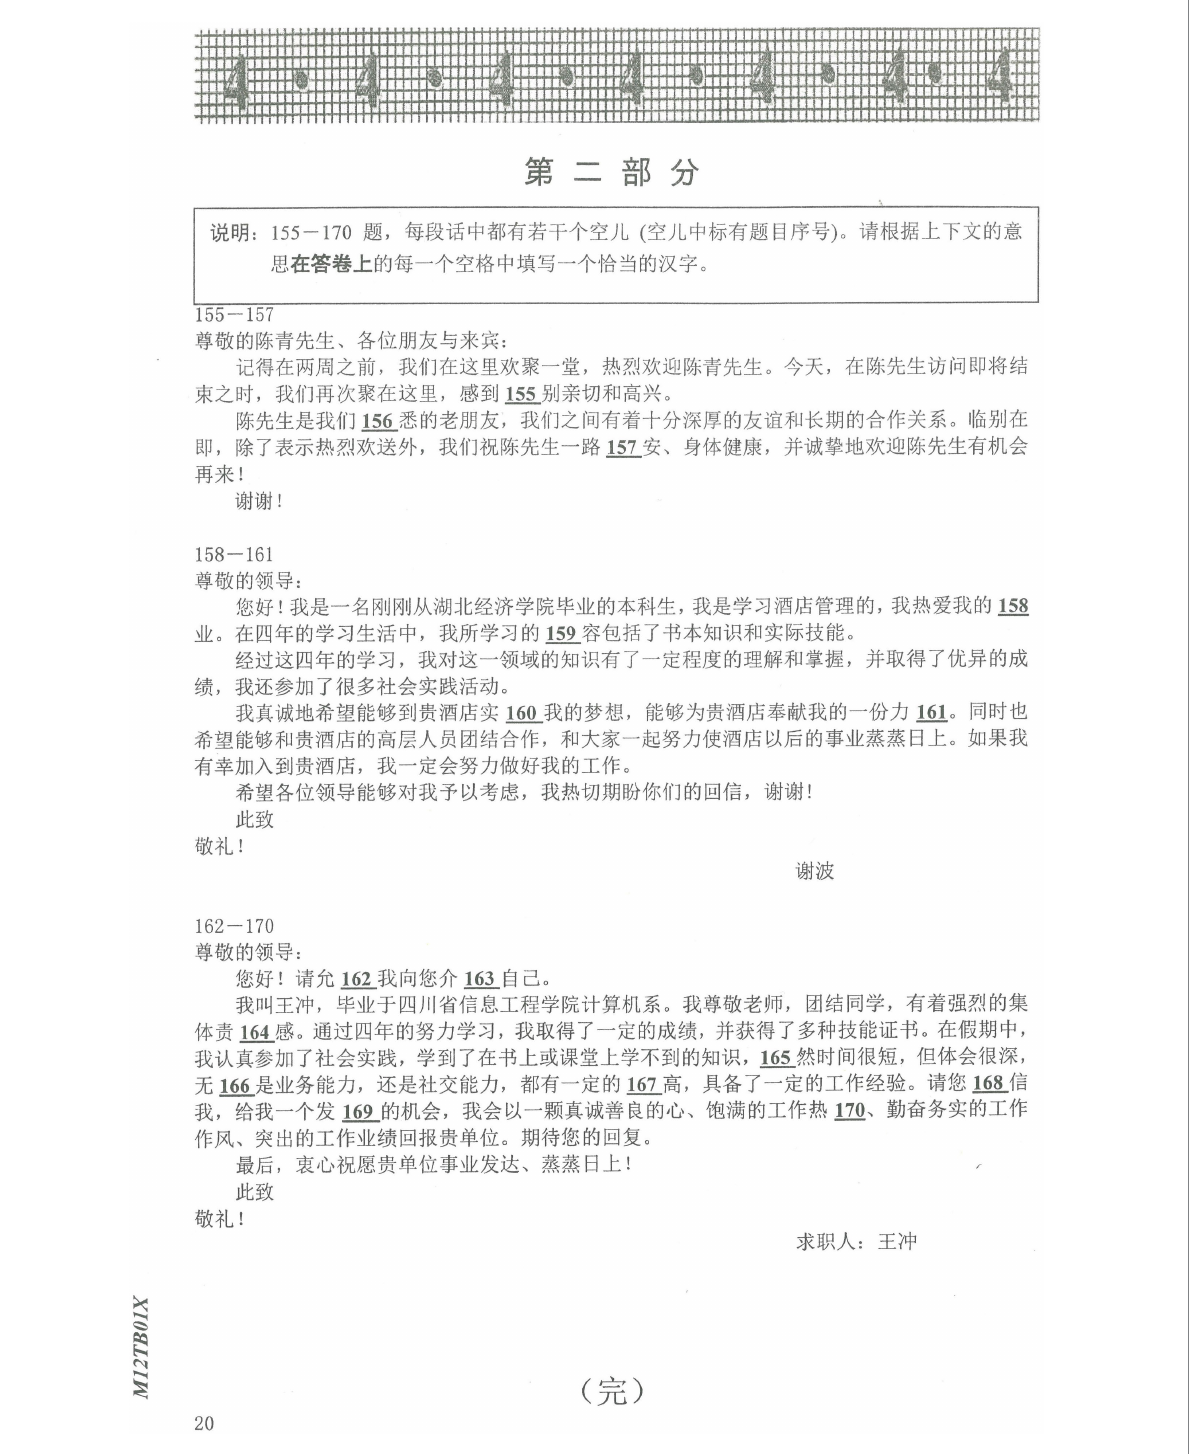
FIGURE 1 Sample test in the HSK character